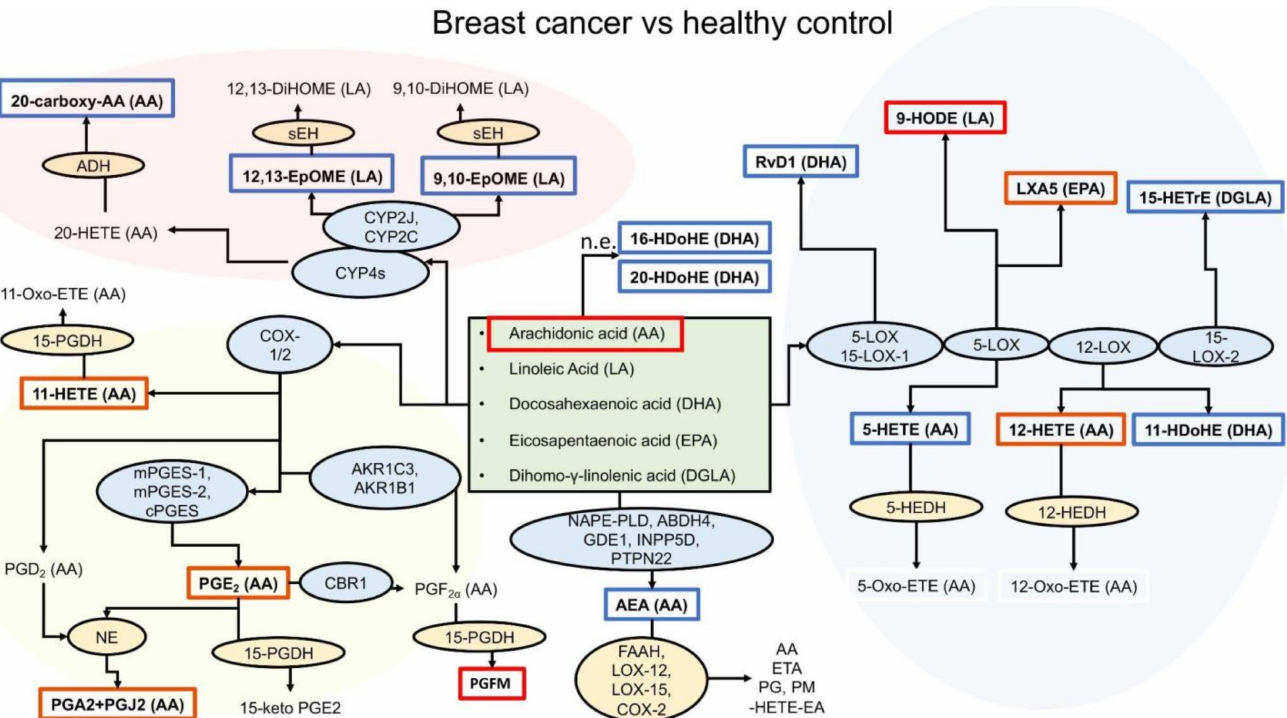
Figure 2. Schema of oxylipin profiles for breast cancer and healthy control donors. Cyclooxyge- nase (COX), lipoxygenase (LOX), cytochrome P450 monooxygenase (CYP450) branches and also anandamide (AEA) pathways and non-enzymatic conversions of PUFAs are noted. Analyzed oxylip- ins are marked with a red frame for induced in BC and a blue frame for reduced in BC